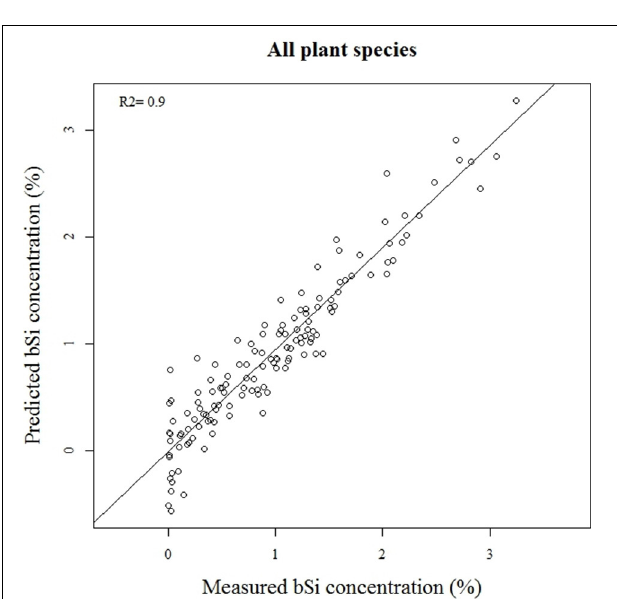
FIGURE 5 | Validation plot of the NIRS calibration model based on samples of all the plant species.